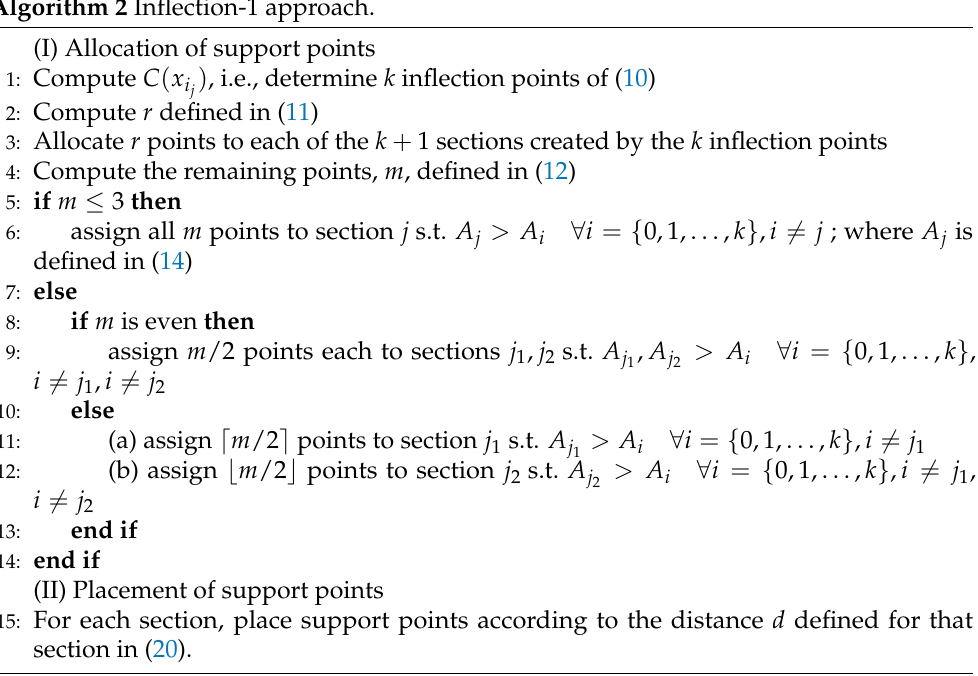
Figure 7. Pictorial representation of inflection-1 approach considering one inflection point. Algorithm 2 Inflection-1